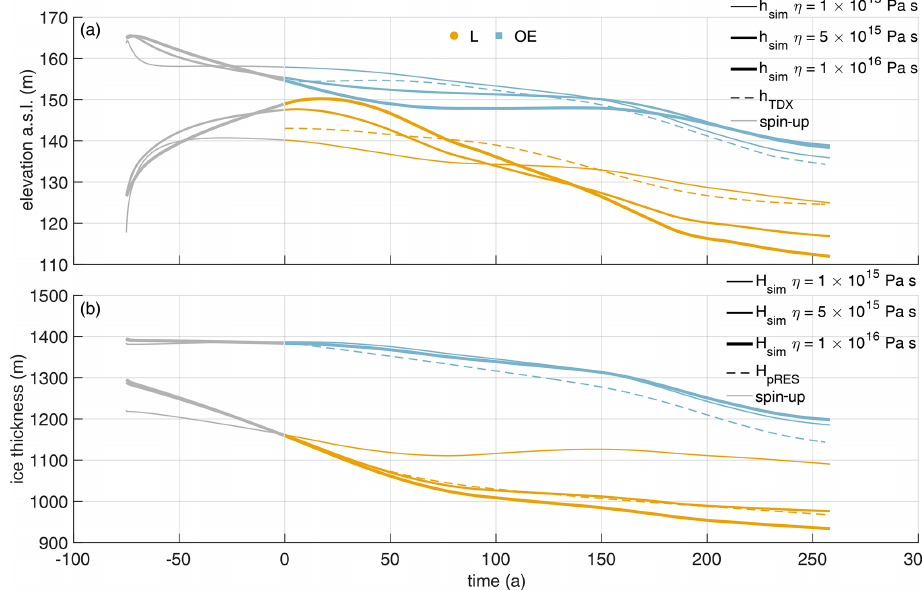
Figure B8. (a) Surface elevation above the channel (yellow) and outside the channel (blue) derived from the simulation (solid lines) and from TanDEM-X DLR (2020) (dashed lines). (b) Ice thickness above the channel (yellow) and outside the channel (blue) derived from the simulation (solid lines) and from pRES measurements (dashed lines). The thickness of the solid lines represents the different viscosities: 1 × 10 15 Pas (thin line), 5 × 10 15 Pas (medium line, same value as in the second experiment) and 1 × 10 16 Pas (thick line). Gray lines represent values used in the spin-up and colored lines values used in the simulation of the evolution of the channel.